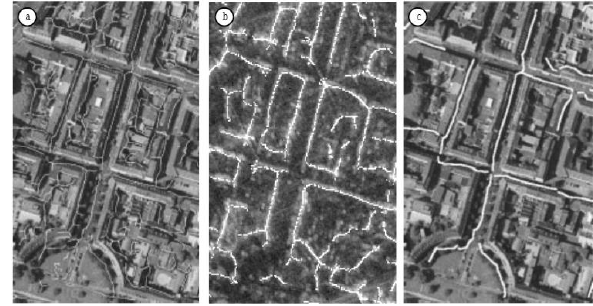
Figure 5: The segmented lines, i.e. road candidates, from the visual image (a) must be accompanied by parallel lines as hint for buildingsin the SAR image (b) to verify the road hypothesis (c) [14]